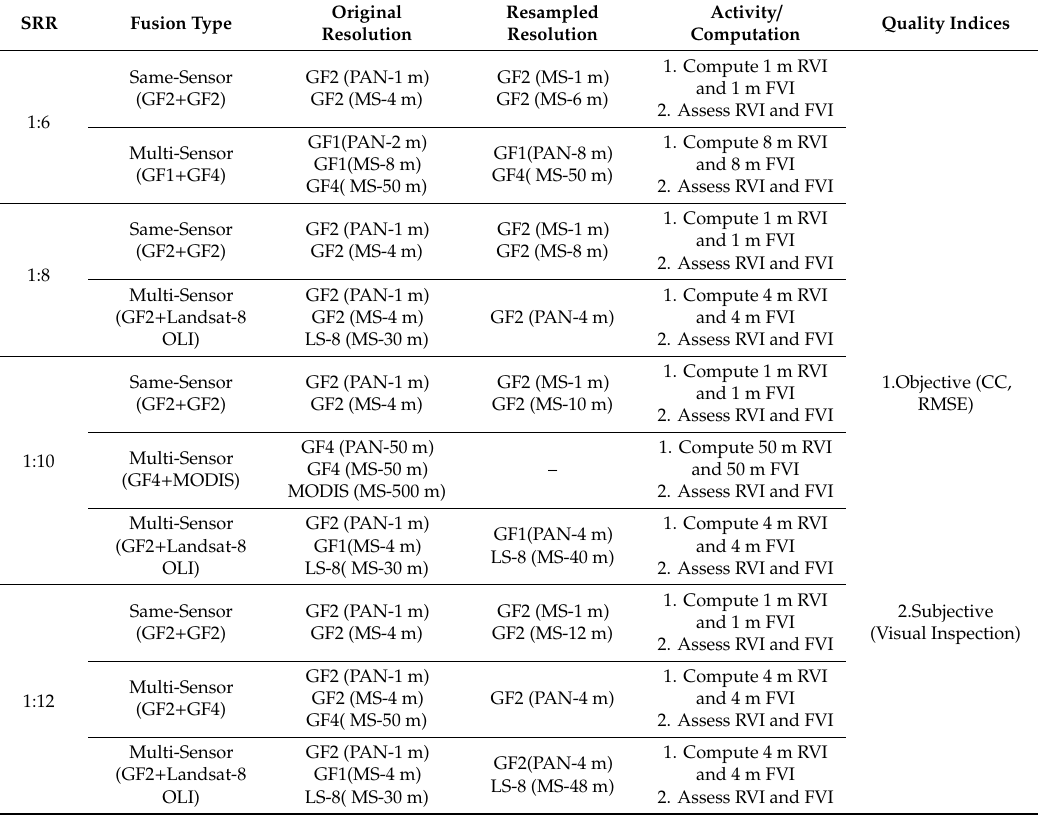
Table 4. Strategy for image fusion and quality